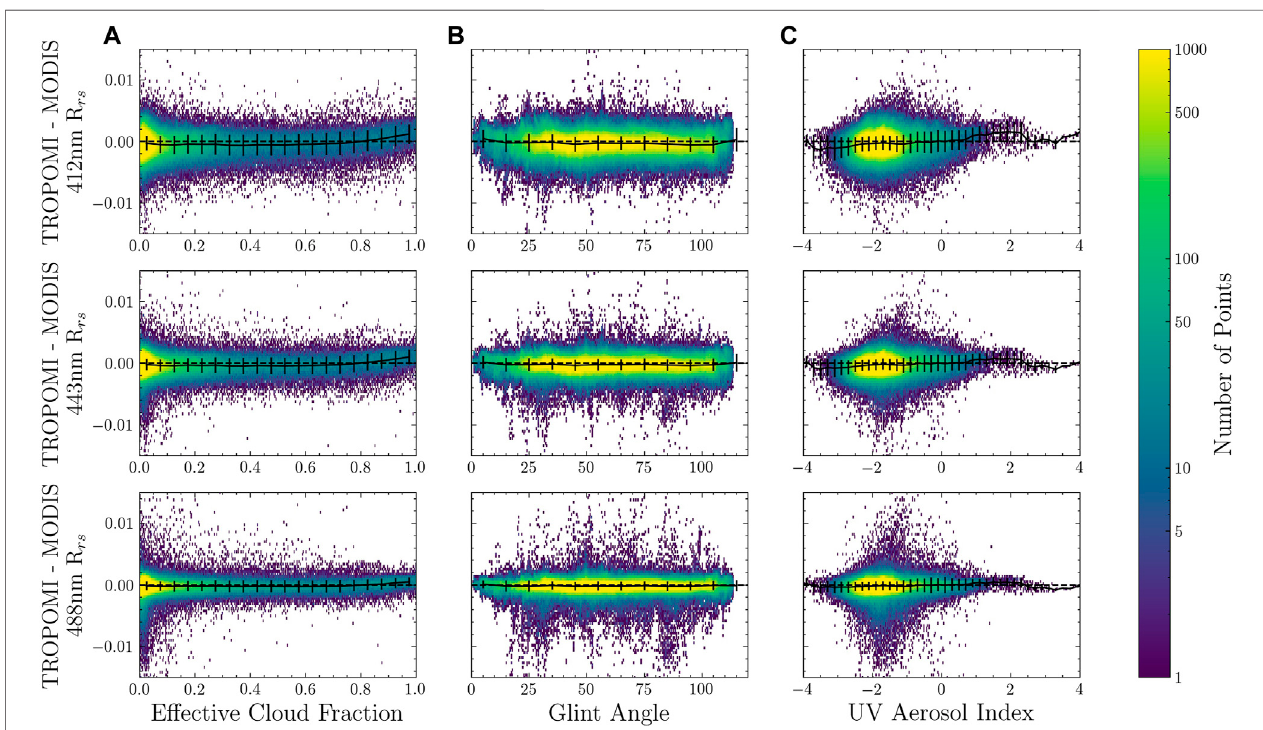
FIGURE 8 | Difference on 15 October 2020 between TROPOMI and MODIS Rrs at 412 nm (top), 443 nm (middle), and 488 nm (bottom) as a function of ECF (A) , glint angle (B) , and aerosol index (C) . The black line represents the mean error with the error bars showing +/ − 1 standard deviation. The data in this fi gure were not screened for clouds, aerosols, or